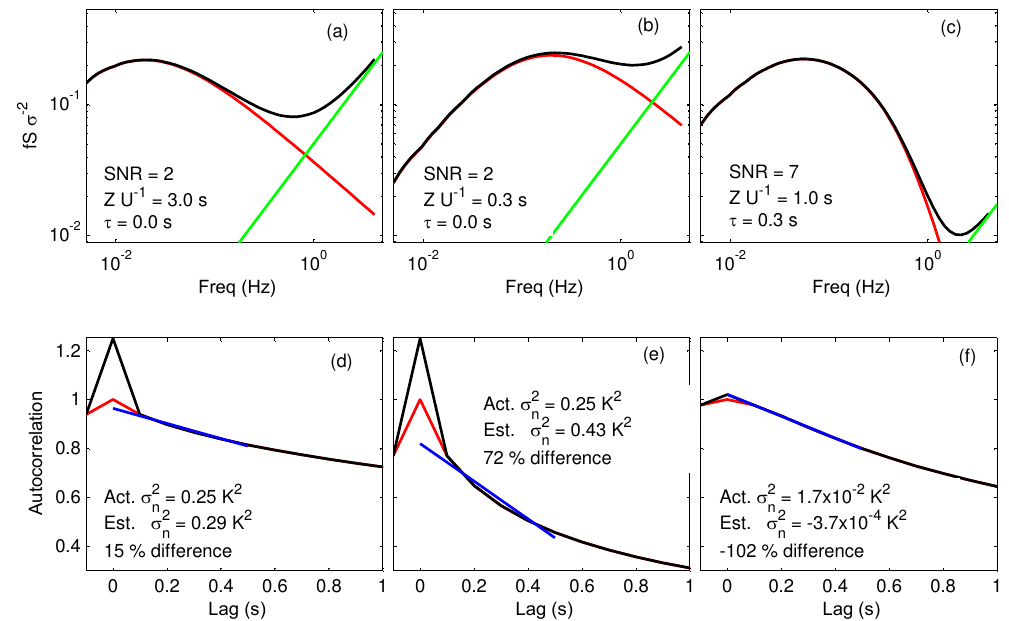
Figure 7. Three example cases for application of the Lenschow et al. (2000) method with presented spectra (upper panels) and auto- correlation functions (lower panels). Case 1 ( a , d ): no filtering, low SNR, high ITS. Case 2 ( b , e ): no filtering, low SNR, low ITS. Case 3 ( c , e ): filtering used, high SNR, moderate ITS. Red lines correspond to the original signal; black lines correspond the original signal (high- passed filtered in case 3) superimposed with the noise; blue lines are the linear fits to the auto-correlation functions for lags from 0.1 to 0.5s; green line in spectral plots indicates the + 1 slope on log–log